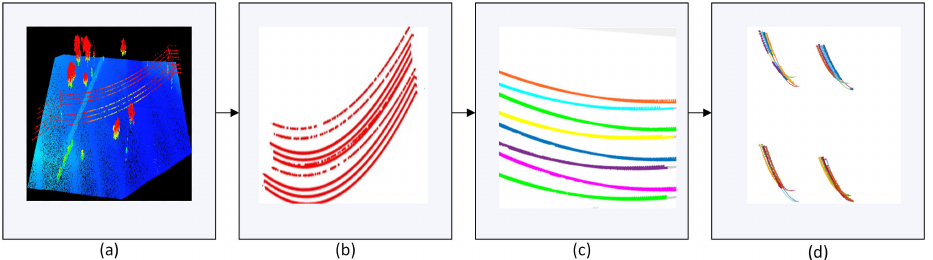
Figure 3. LiDAR data processing methods for power line mapping. ( a ) LiDAR point cloud data; ( b ) separation of power line points Section 3.1, Table 2; ( c ) single power line extraction and reconstruc- tion Section 3.2, Table 3; ( d ) multi-conductor power line extraction and reconstruction, Section 3.2, Table